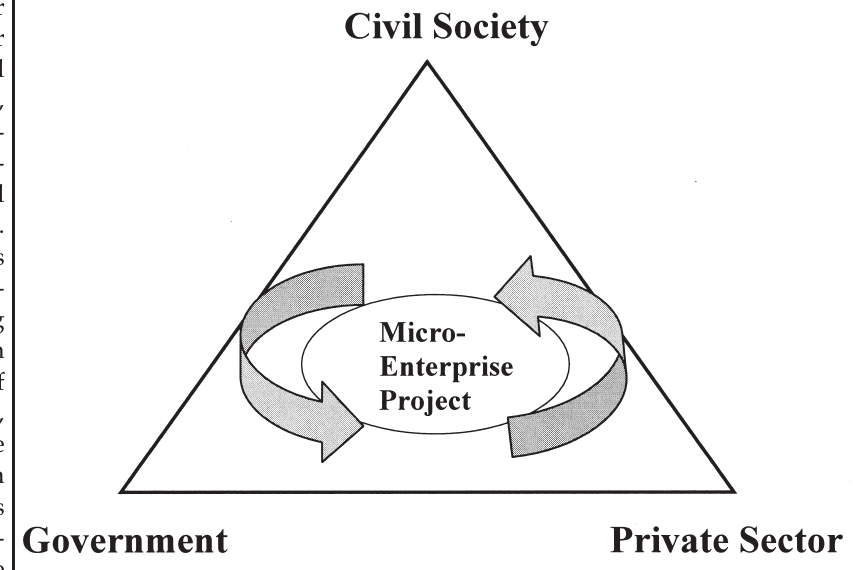
Figure 2. Project-Based Knowledge Management